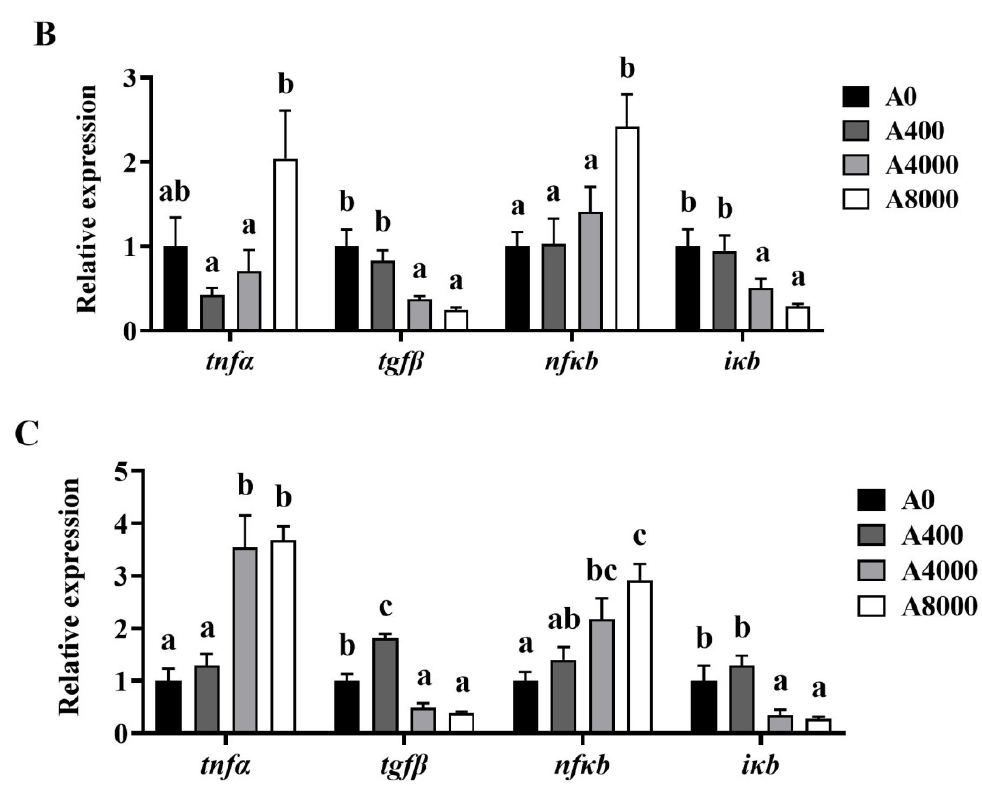
Figure 5. Effects of dietary AMP on expression of inflammatory-related genes in the liver ( A ), intestine ( B ), and kidney ( C ). tnf α : Tumor necrosis factor α ; tgf β : Transforming growth factor β ; nf κ b : Nuclear factor-kappa B; i κ b : Inhibitory protein of nuclear factor-kappa B. Data are shown as mean ± SEM ( n = 6). Different lowercase letters represent significant differences among all groups ( p < 0.05).